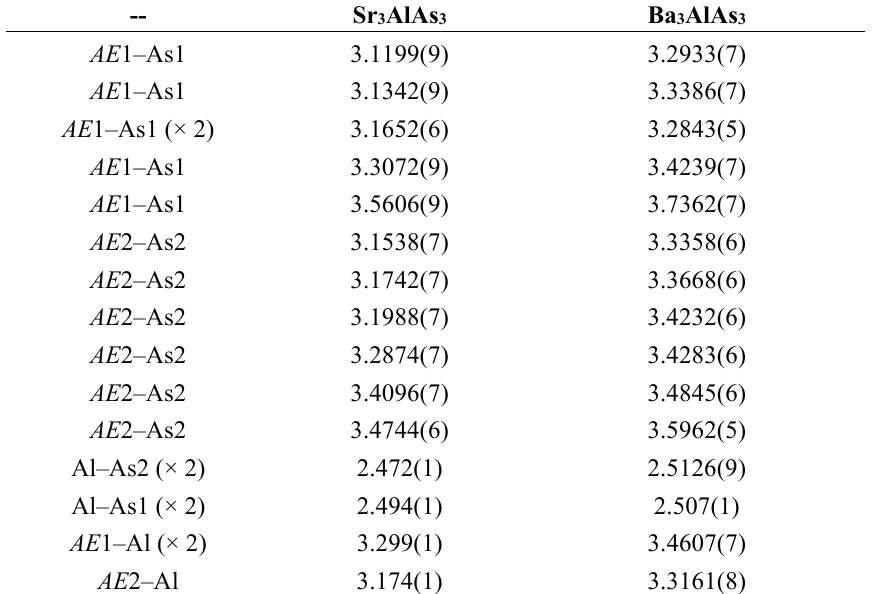
Table 3. Selected interatomic distances (Å) in AE 3 AlAs 3 ( AE = Sr,